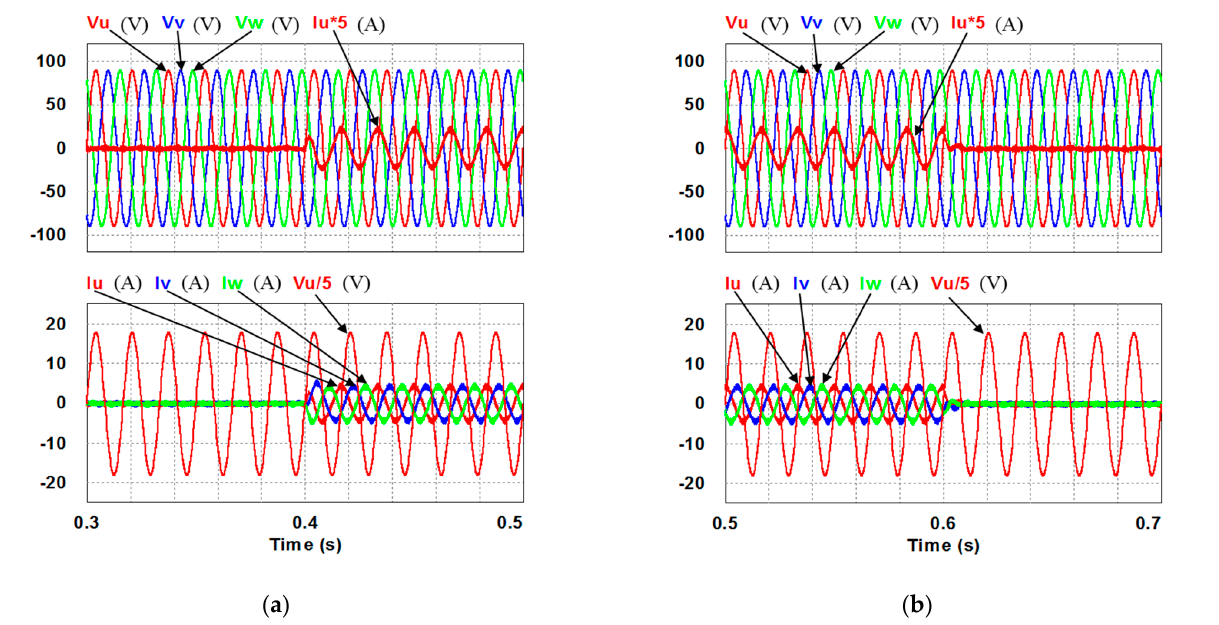
Figure 15. Detailed views of Figure 14 b : ( a ) from 0.3 to 0.5 s; ( b ) from 0.5 to 0.7 s.